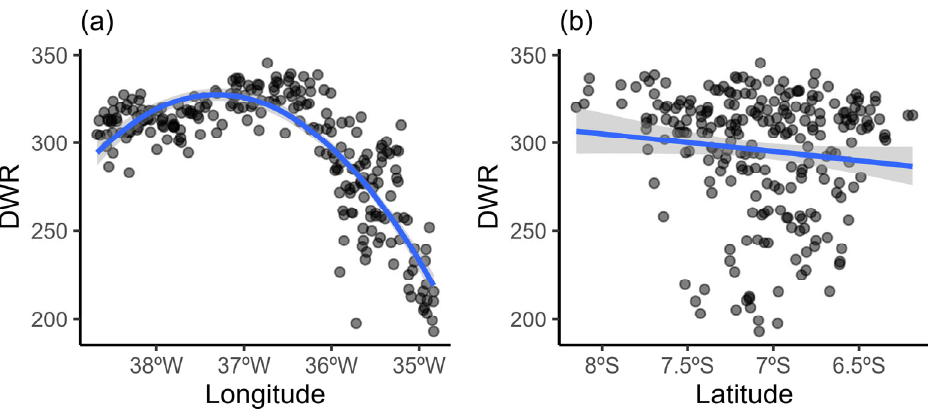
Figure 4. Analysis of the trend between the annual number of days without rain (DWR) and the geographic coordinates longitude ( a ) and latitude ( b ) in the state of Para í